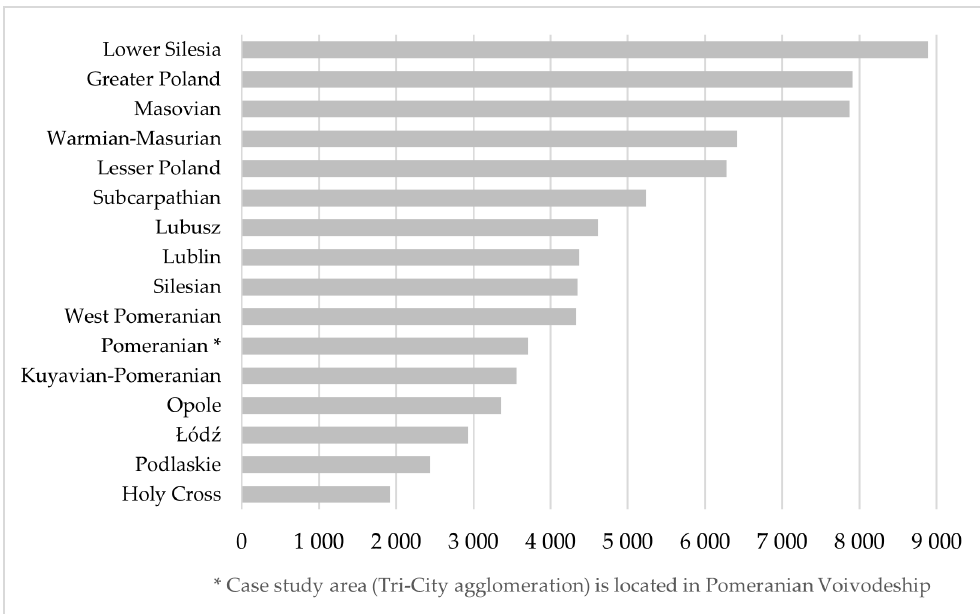
Figure 1. The number of non-moveable monuments in voivodeships of Poland. Source: own elaboration on the basis of the data from The National Heritage Board of